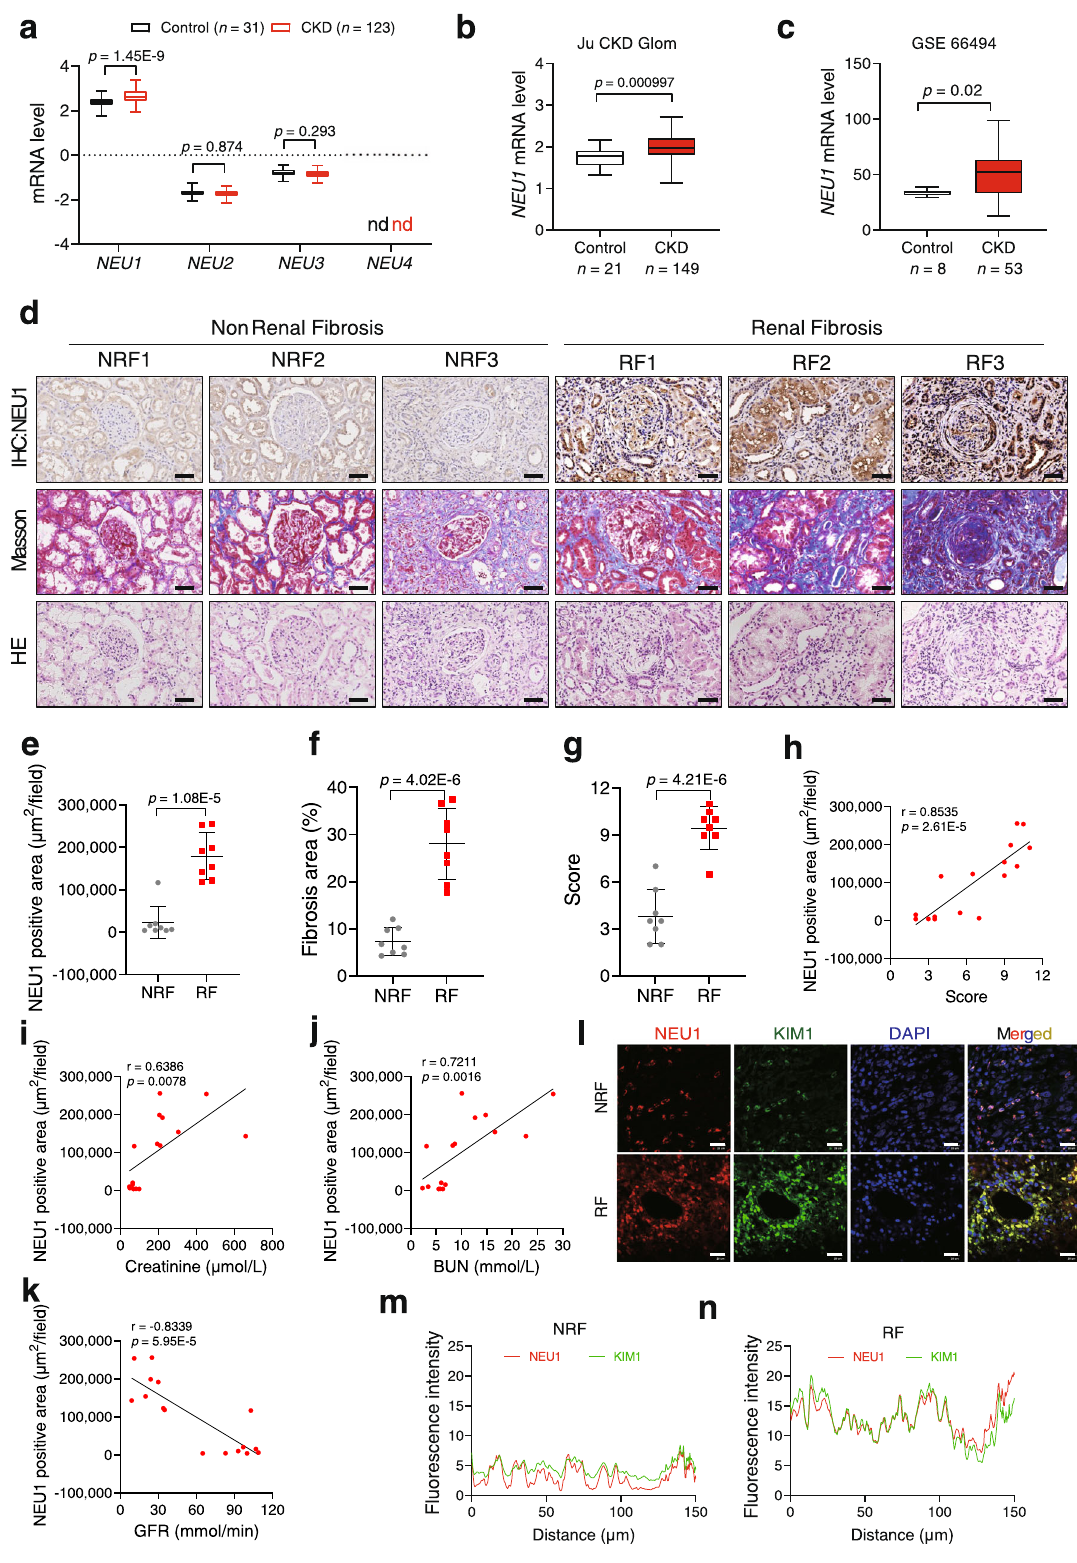
in fl ammation (Fig. 3b, e, f), suppressed macrophage in fi ltration (Fig. 3b, g) and nuclearphosphorylated NF- κ B (pNF- κ B) in tubularcells (Fig. 3b, h). NEU1 de fi ciency markedly inhibited UUO-induced KIM1 expression (Fig. 3i).Immuno fl uorescenceshowed thatpartialEMTwas inducedbyUUO,asevidencedbytheremnantsofTECinthebasement membrane and co-expression of epithelial cell marker E-Cadherin and